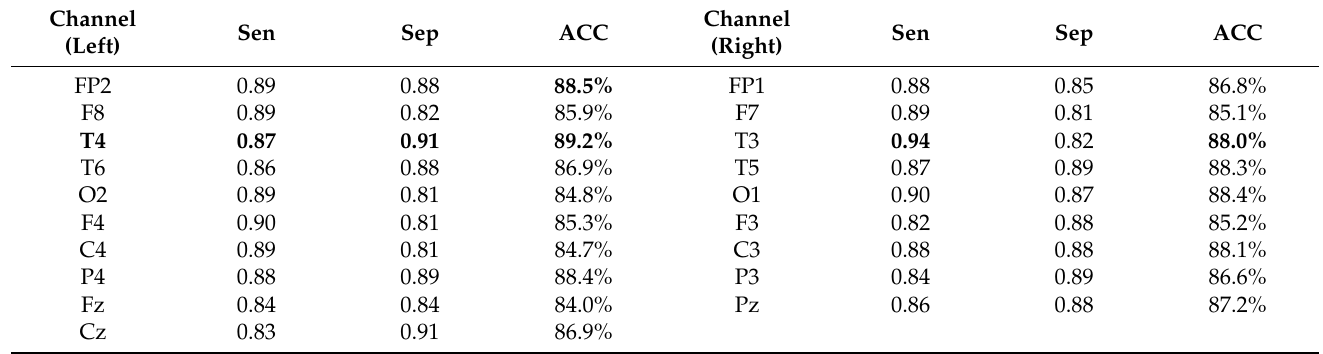
Table 2. The classification results based on leave-one-out cross-validation using a single channel per time for eyes-open status.